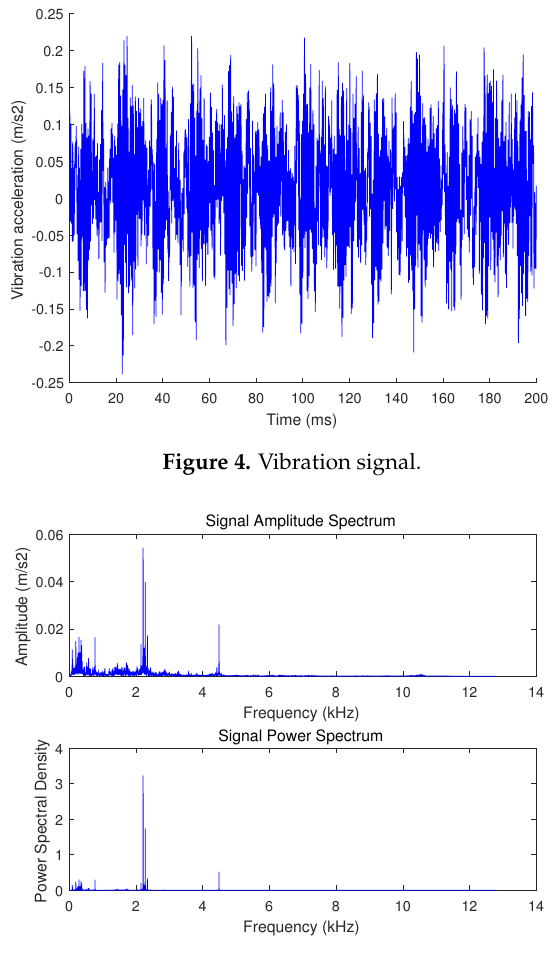
Figure 5. Amplitude spectrum and power